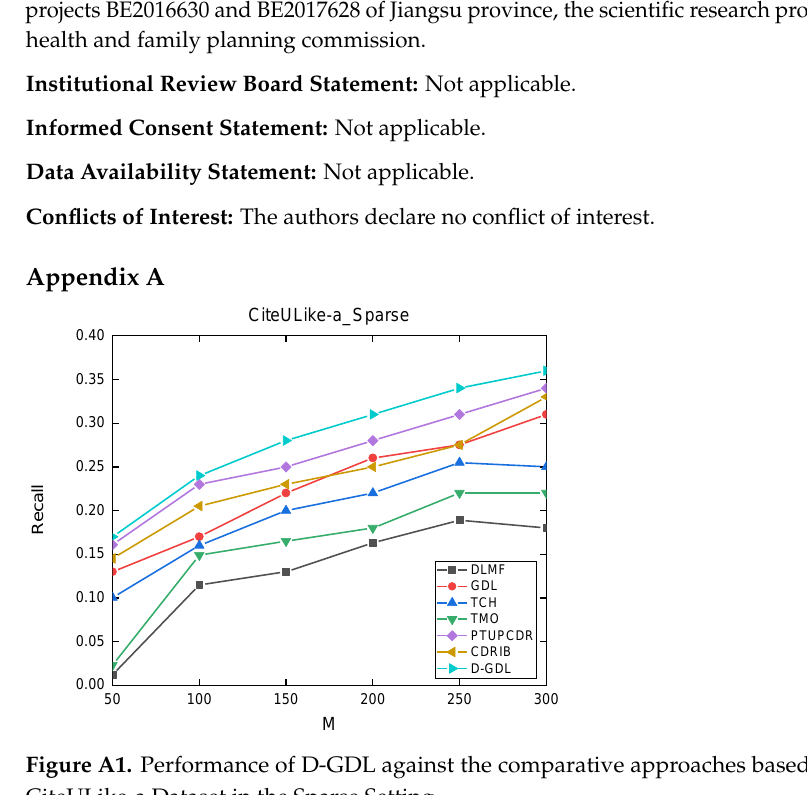
Figure A2. Performance of D-GDL against the comparative approaches based on Recall vs. M for CiteULike-t dataset in the sparse setting.